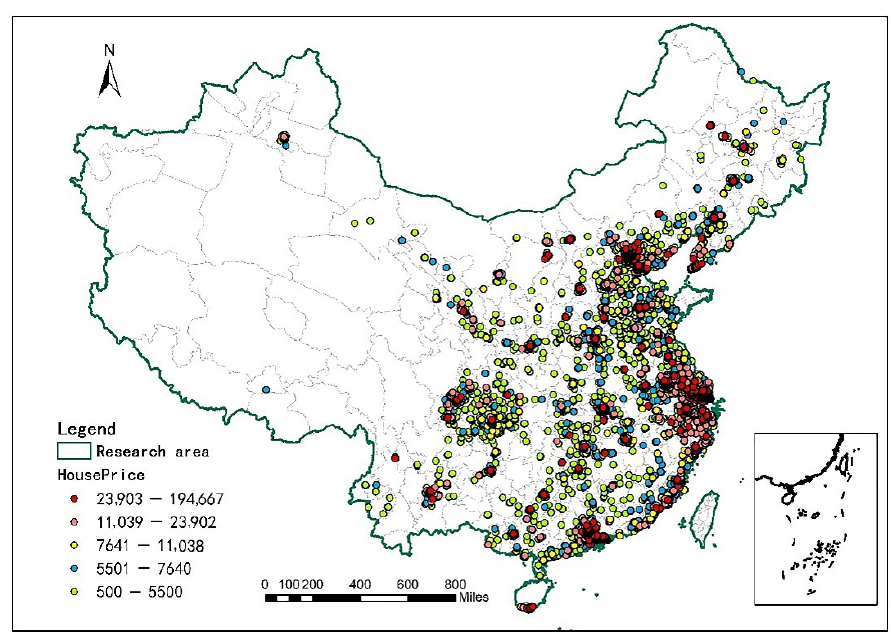
Figure 5. Location and average house price of the study